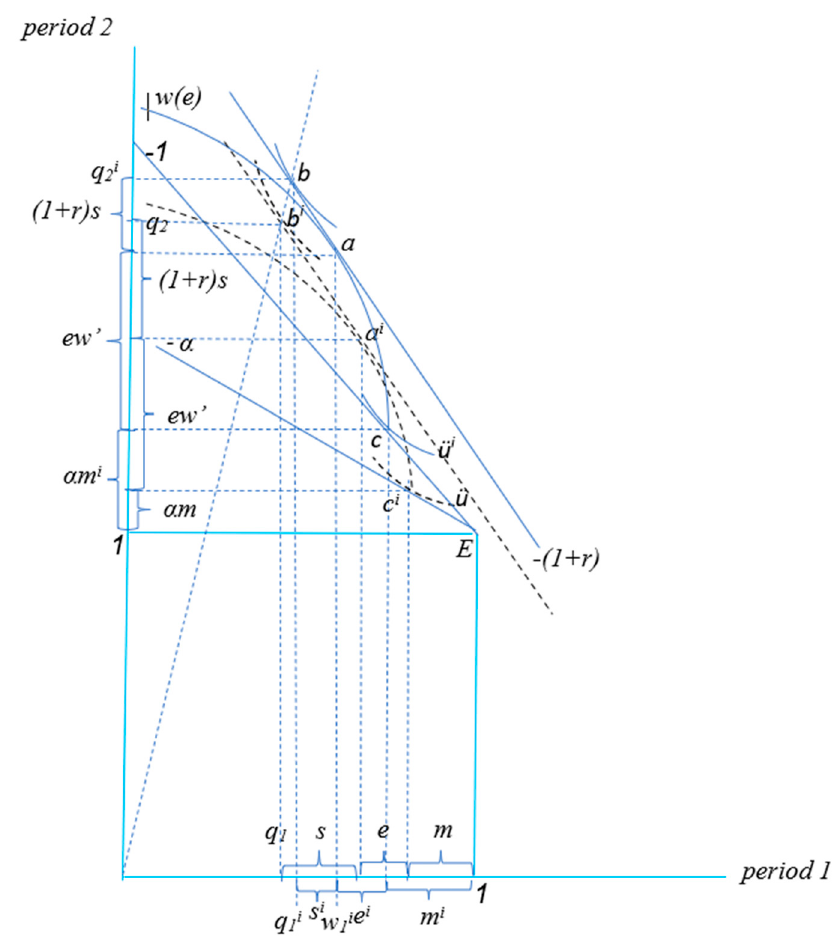
Figure 3. Absolute money illusion in the life-cycle